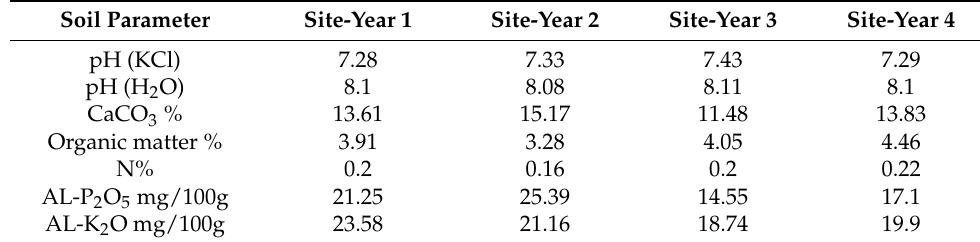
Table 4. Results from the laboratory analysis of the soil samples collected from each site-year. Soil